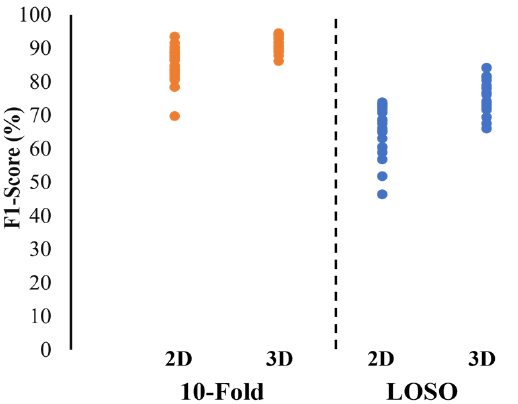
Figure 4. Distribution of F1 score for all models trained with various parameters.